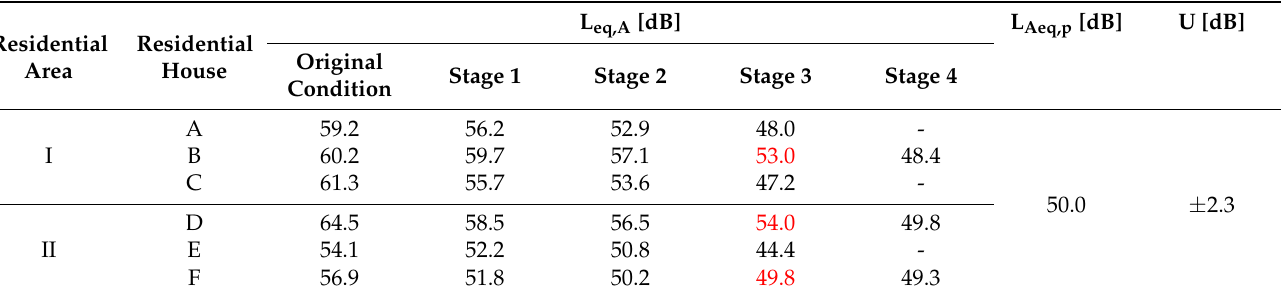
Table 4. Noise values measured in residential